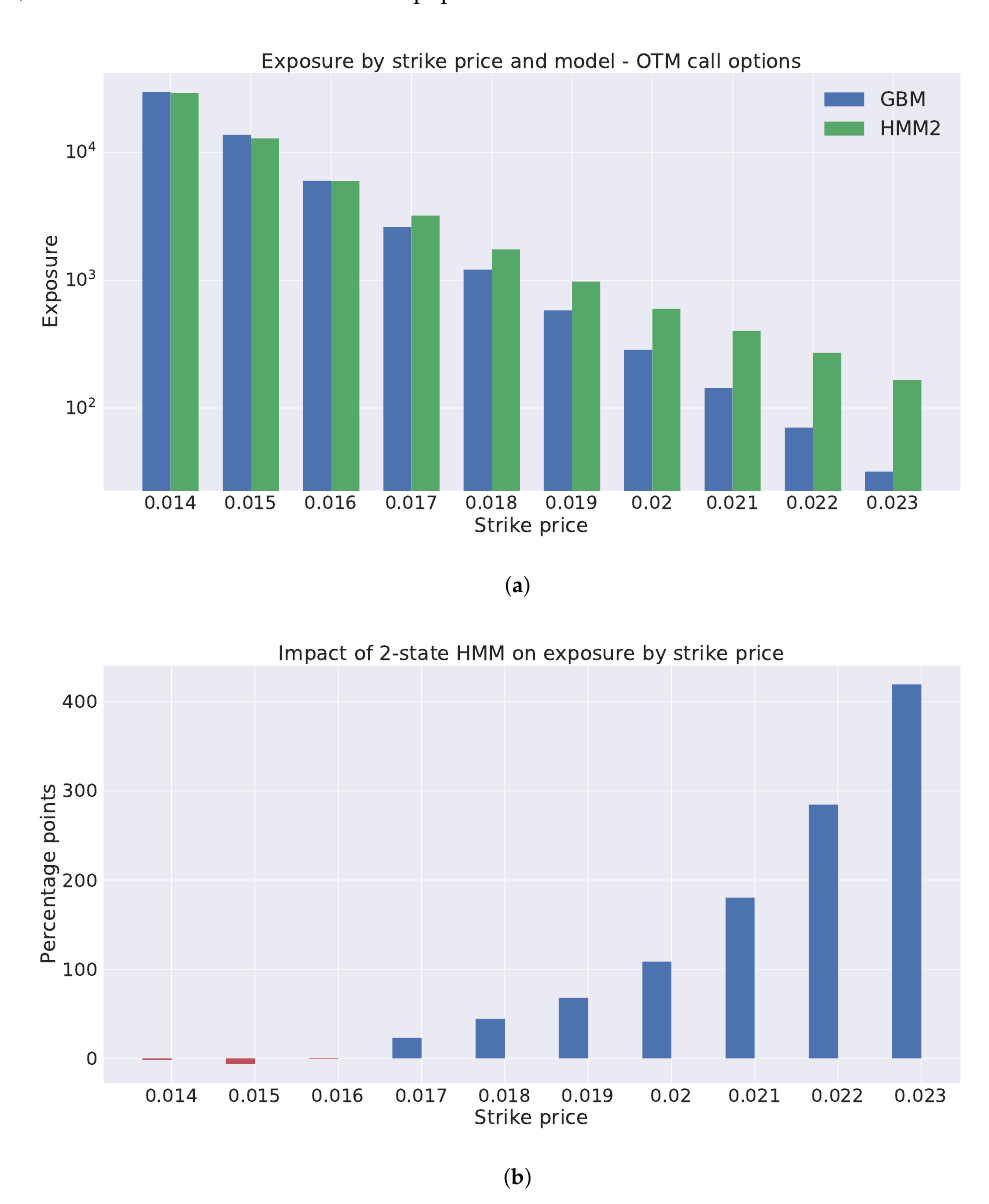
Figure 11. Credit exposure values for out-of-the-money (OTM) call options on the RUB/EUR exchange rate ( a ) and the impact of using a two-state HMM, instead of a GBM ( b